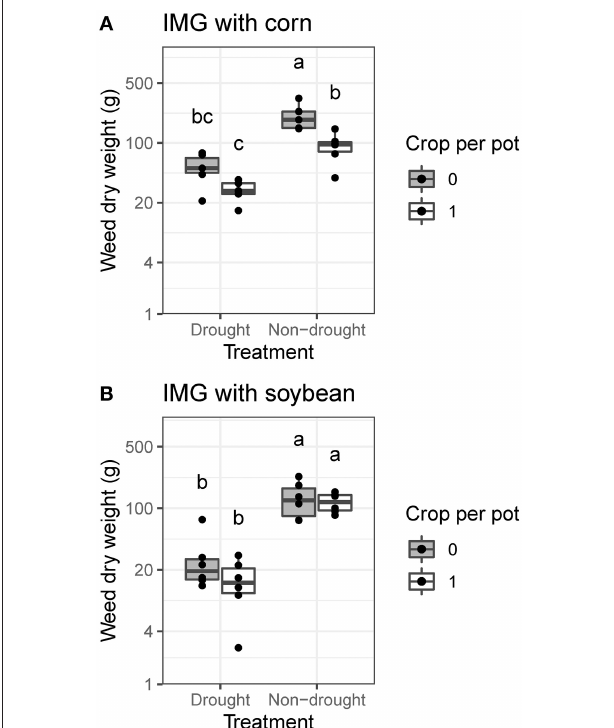
FIGURE 3 | Effects of drought treatment and crop competition on ivyleaf morningglory (IMG) biomass under greenhouse conditions. Pots with a single IMG plant (0R1W) are compared to pots with one crop plant and one IMG plant (1R1W). Data are presented for IMG grown with (A) corn and (B) soybean. Within crop species, treatments labeled with the same letter are not significantly different according to Tukey’s HSD test ( α = 0.05).